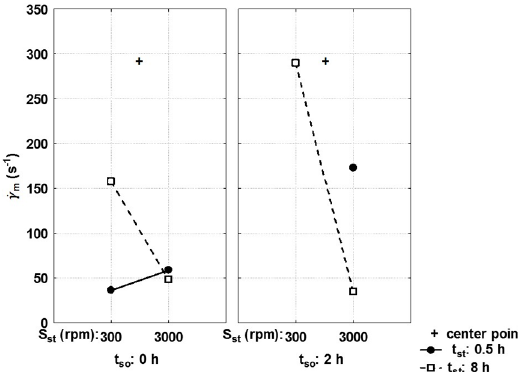
Figure 5. Means plot for maximum critical shear rate m c o . Symbols (+) are related to center point average.